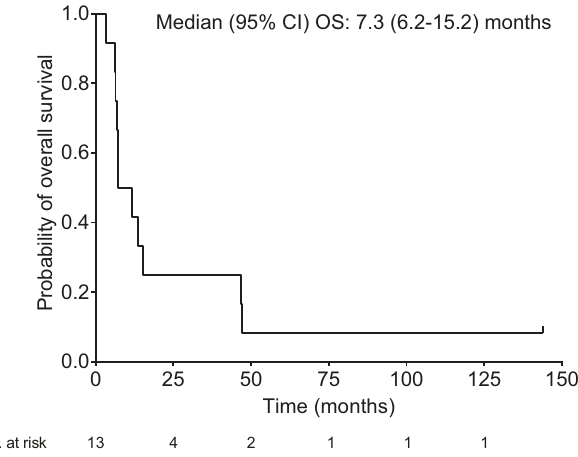
Fig. 1 Kaplan – Meier curve for overall survival from the last G47 Δ administration (FAS population; N = 13). Source data are provided as a Source Data fi